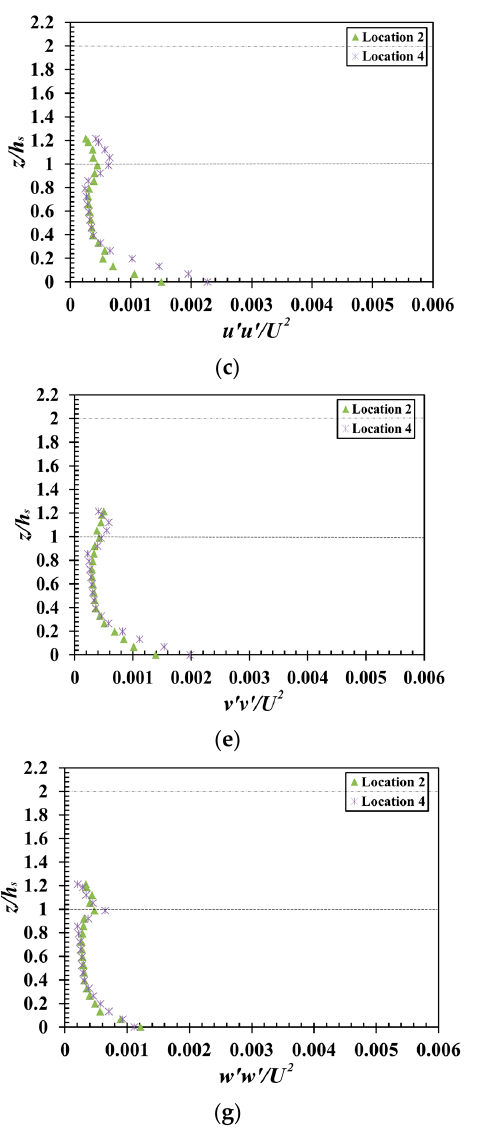
Figure 9. Simulated profiles of Reynolds stresses and normal stresses at typical locations (2 and 4) for Case A ( a , c , e , g ) and for Case B ( b , d , f , h ). The lower and upper dotted lines represent the top of vegetation layers 1 and 2, respectively.